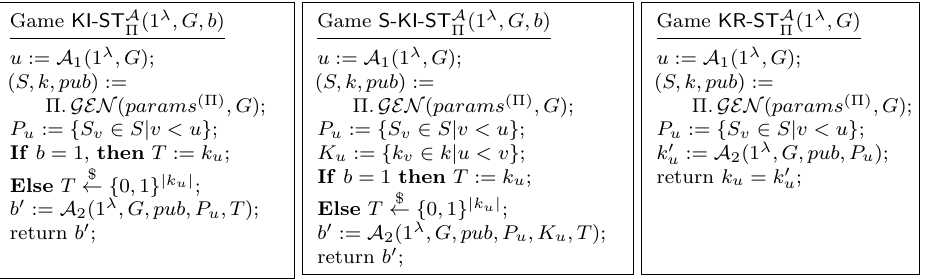
Figure 3: Games defining KI-ST , S-KI-ST and KR-ST security of KAS scheme Π = (Π . GEN , Π . DER ). Here, the adversary A = ( A 1 , A 2